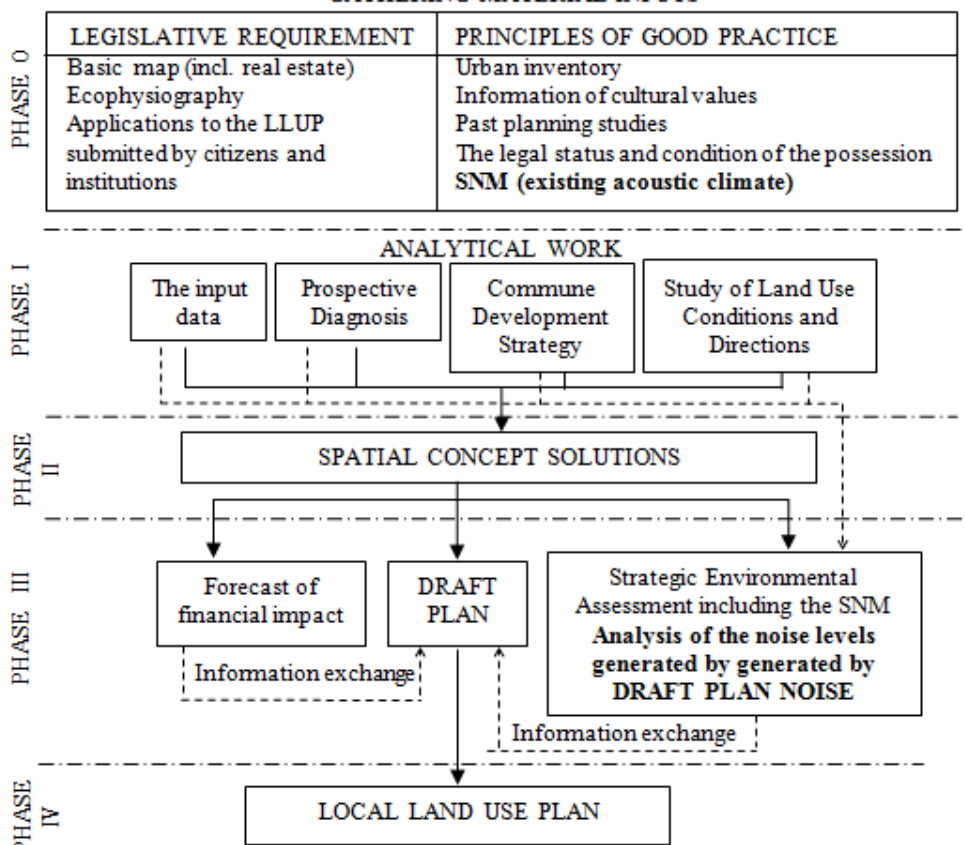
Figure 1. Stages of Local Land Use Plan including Strategic Noise